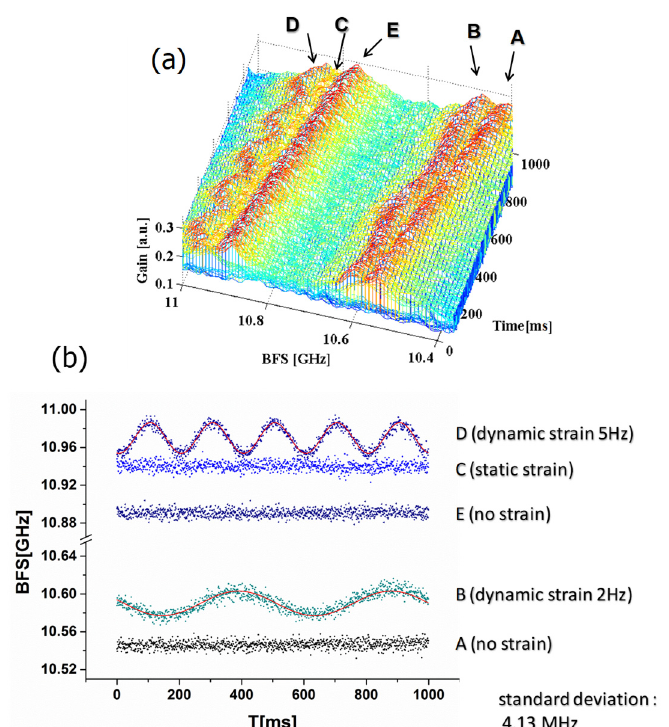
Figure 30. Experimental results of 5000 point/s high-speed random accessibility measurement by the system shown in Figure 29; five points are selected arbitrarily along the fiber [67]. Simultaneous dynamic strain measurements can equivalently be realized. ( a , b ) are the BGS and BFS change as a function of time,